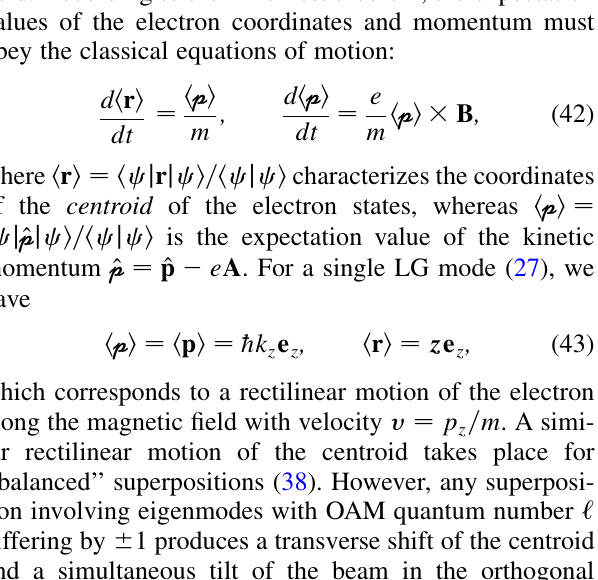
, Y ¼ y=w , and Z ¼ z=z m m m